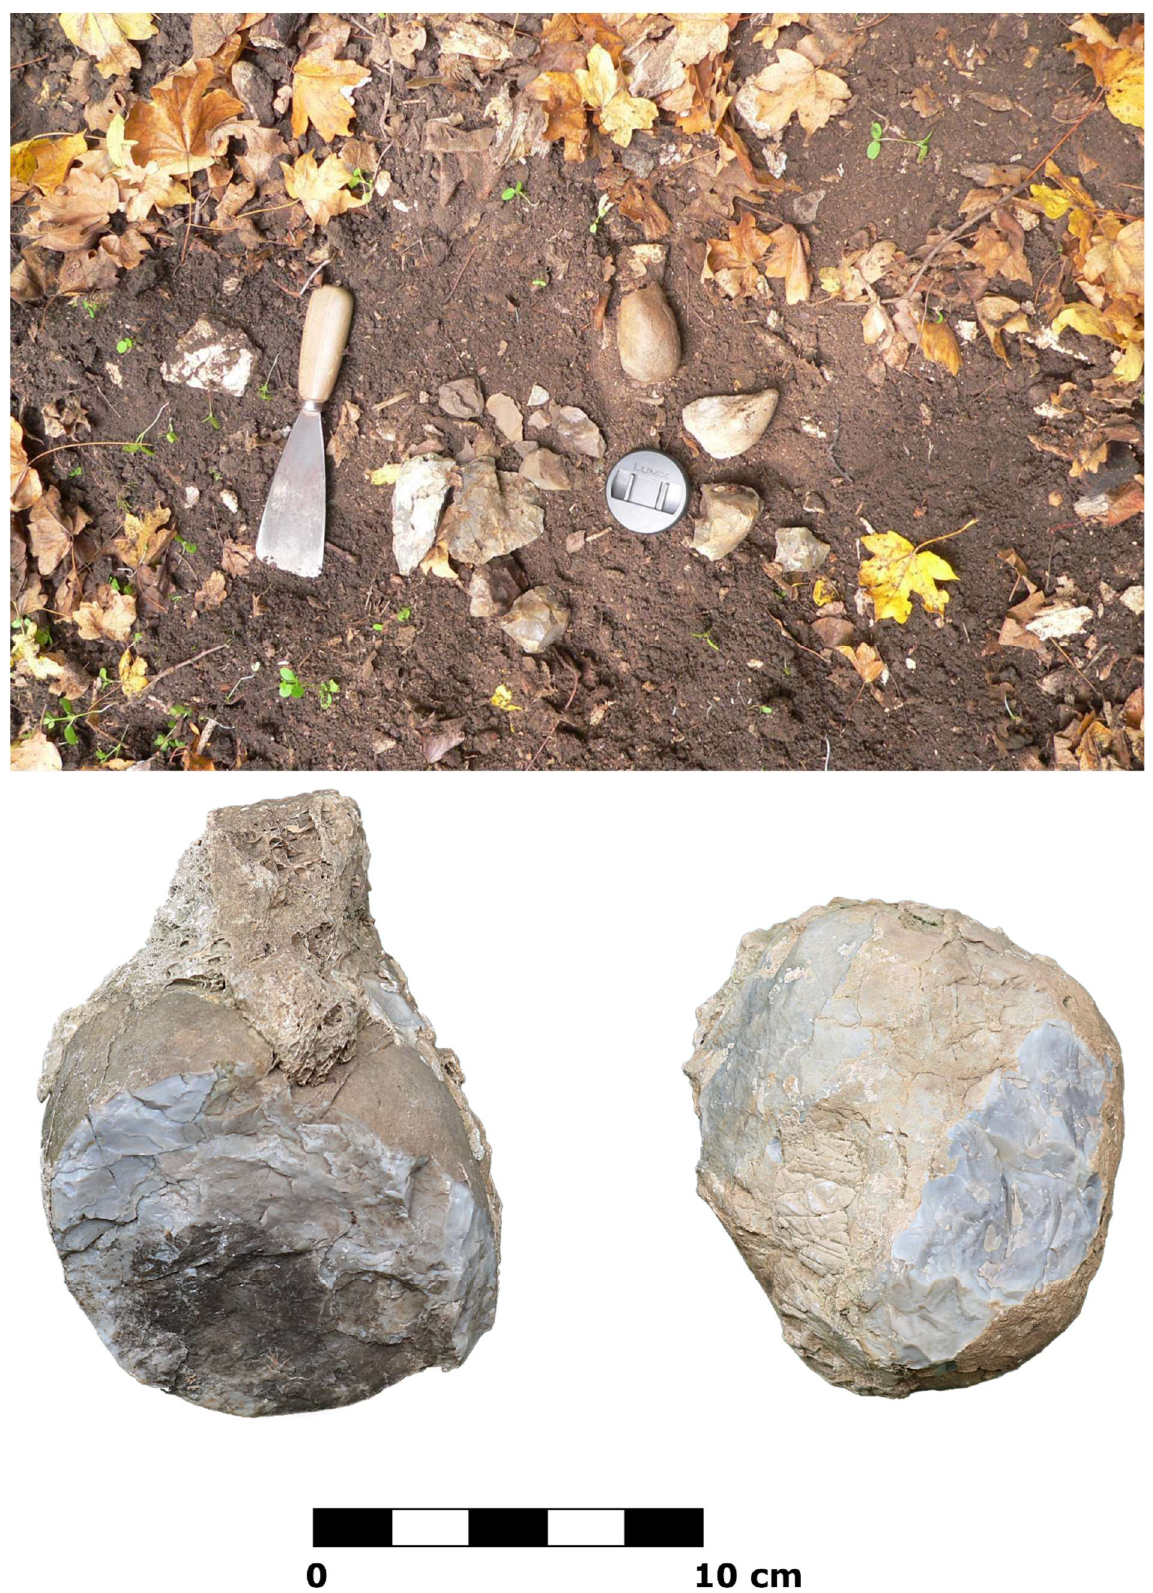
Figure 8. Buda hornstone of the Buda Hills from Farkas-völgy 1. A: knapped flakes and fragments of a hammerstone in a supposed pit; B: tested nodules. (Photo and CAD by Z. Mester and N. Faragó) Figure 8. Chaille de Buda des monts de Buda provenant de Farkas-völgy 1. A: éclats taillés et fragment de percuteur dans une fosse d’extraction supposé; B: rognons testés. (Cliché et DAO: Zs. Mester et N.